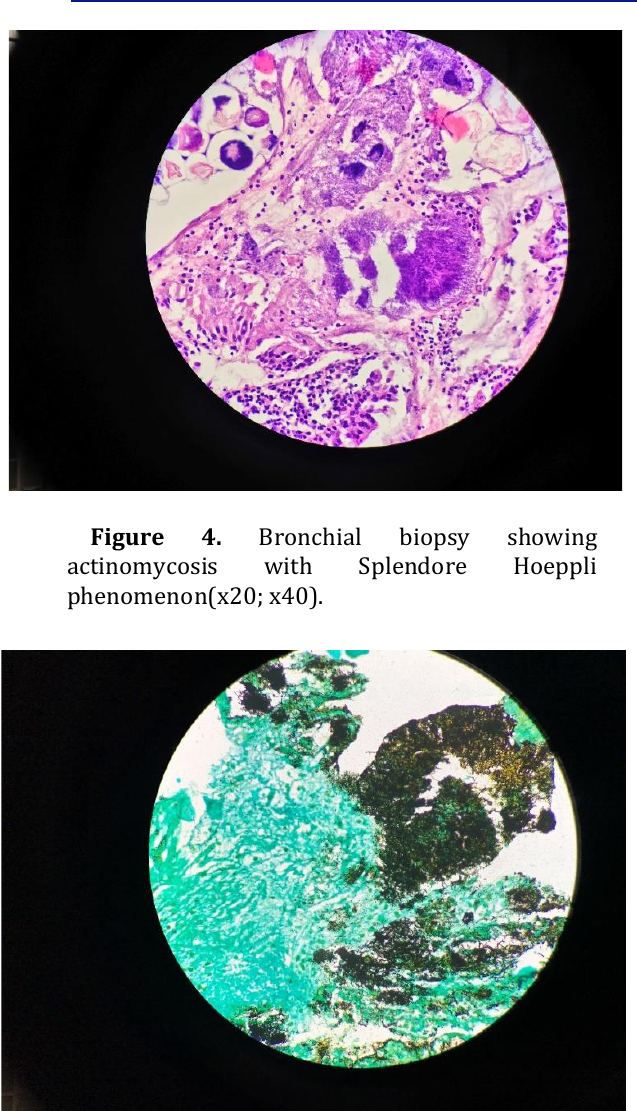
Figure 5. Silver methanamine stain showing actinomycosis (x 20).